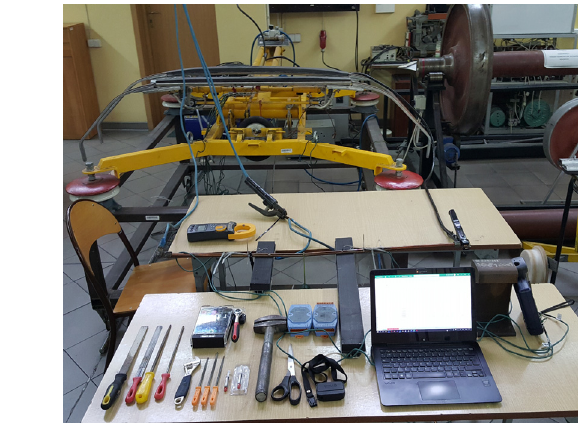
Figure 1. Pantograph equipment is used for research and contact strip material testing [21].